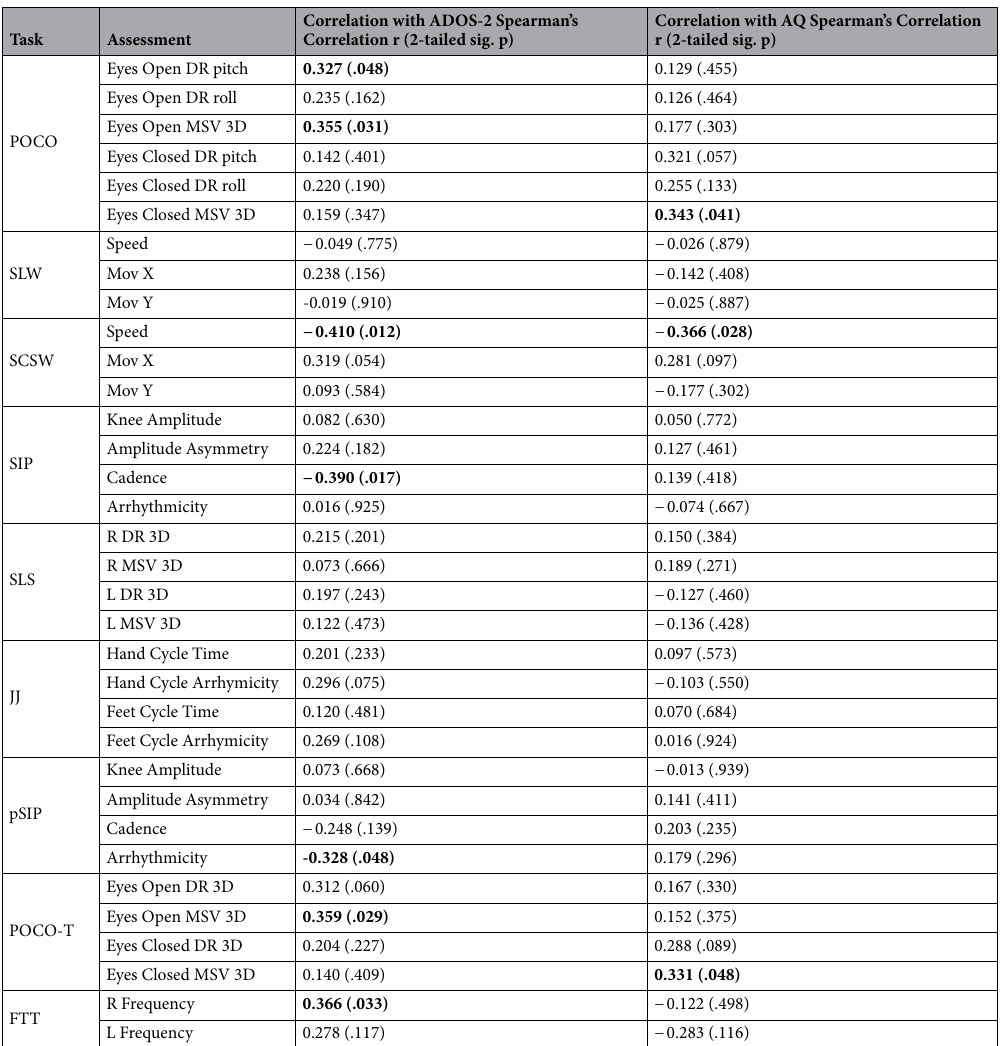
Table 5. Correlation of quantitative motor outcomes in relation to the ADOS-2 score and AQ score in adults with ASD. ADOS-2 score = Autism Diagnostic Observation Schedule module 4 total score, AQ = Autism Spectrum Quotient, ASD = autism spectrum disorder, DR 3D = deflection range in 3D, MSV 3D = mean sway velocity in 3D, Mov X = movement deviation in mediolateral direction, Mov Y = movement deviation in anteroposterior direction at hip level, R = right, L = left, POCO = postural control stance, POCO-T = postural control tandem stance, SLS = single leg stance, SLW = line walk, SCSW = walk at a subjectively comfortable speed, SIP = stepping in place, pSIP = paced stepping in place, JJ = jumping jack, FTT = finger tapping test. For description of movement tasks see Table 1. Significant values are in